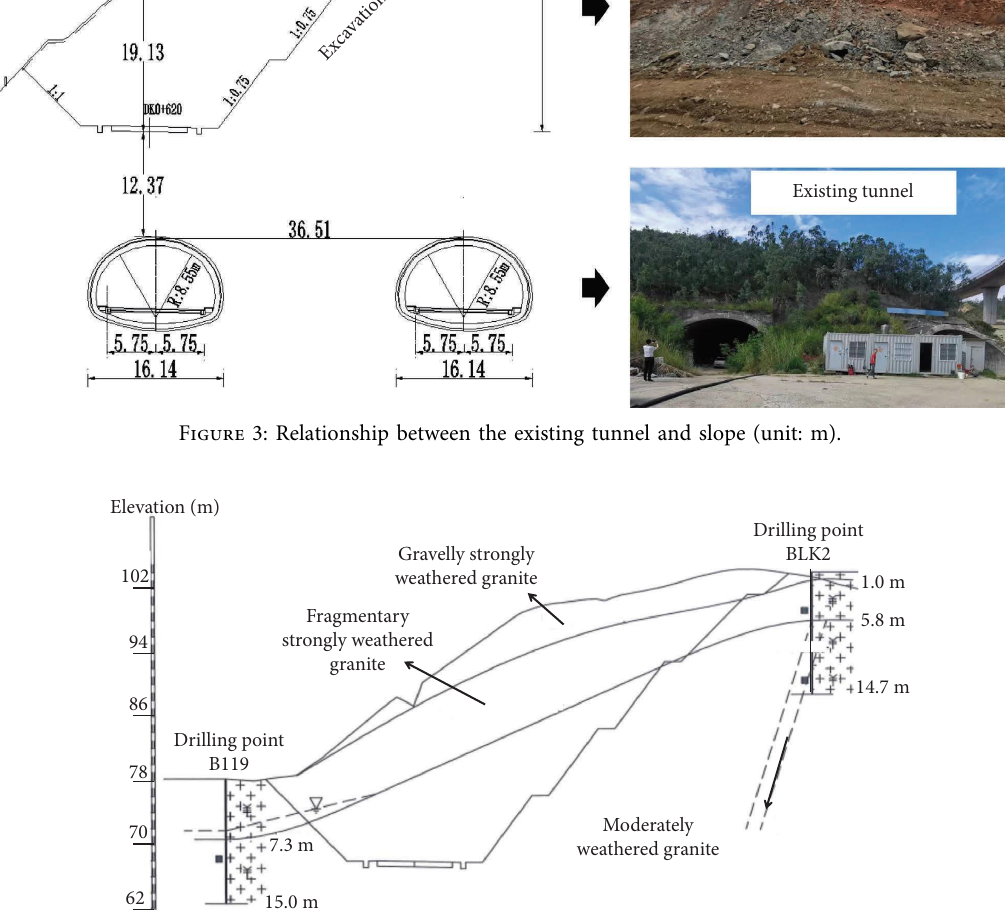
Figure 4: Engineering geological section (unit: